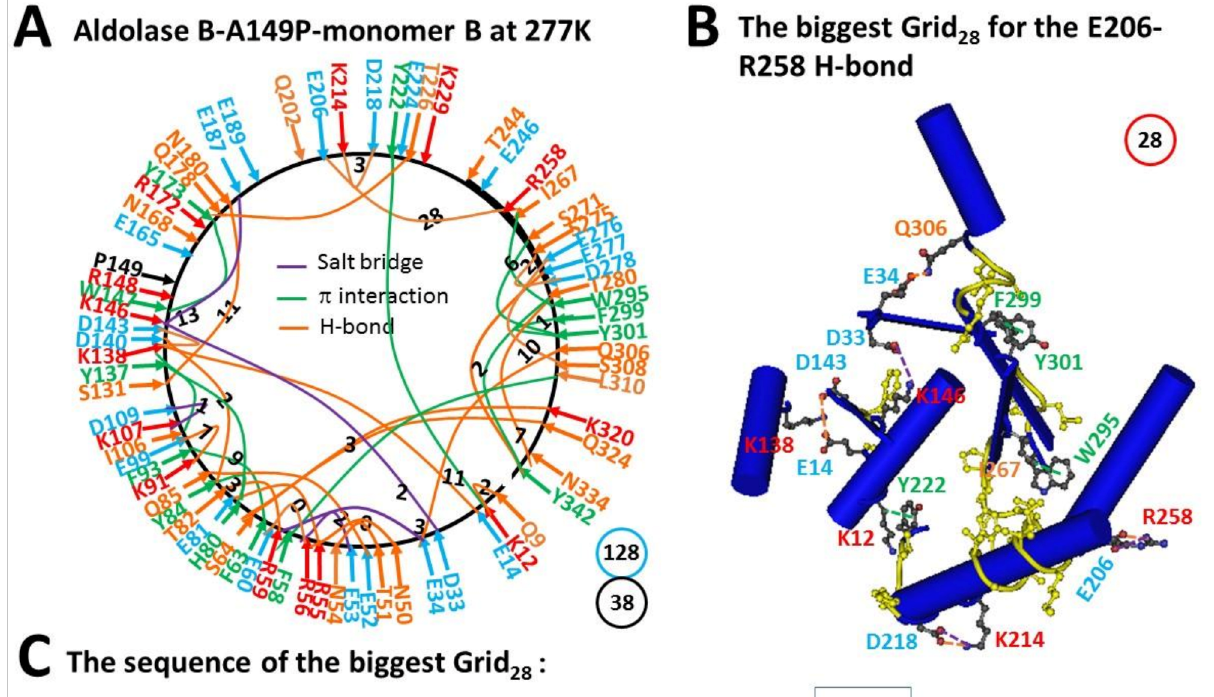
Figure 1. The grid-like non-covalently interacting mesh network along the single polypeptide chain of ligand-free monomer B in the aldolase B-A149P tetramer at 277 K. ( A ) The topological grids in the systemic fluidic grid-like mesh network. The X-ray crystallographic structure of monomer A in aldolase B-A149P at 277 K (PDB ID, 1XDL) was used for the model [2]. Salt bridges, π interactions, and H-bonds between pairing amino acid side chains along the single polypeptide chain from T8 to Y342 are marked in purple, green, and orange, respectively. The grid sizes required to control the relevant non-covalent interactions were calculated with graph theory and labeled in black. The total grid sizes and grid size-controlled non-covalent interactions along the single polypeptide chain are shown in the blue and black circles, respectively. ( B ) The structure of the biggest Grid 28 . The grid size is shown in a red circle. ( C ) The sequence of the biggest Grid 28 to control the E206-R258 H-bond in a blue